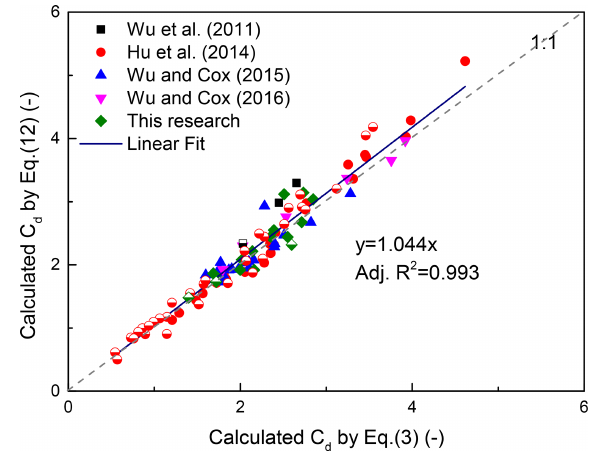
Figure 5. Comparison of the calculated values of C D by Eqs. (3) and (5). Details are the same as Fig. 4.